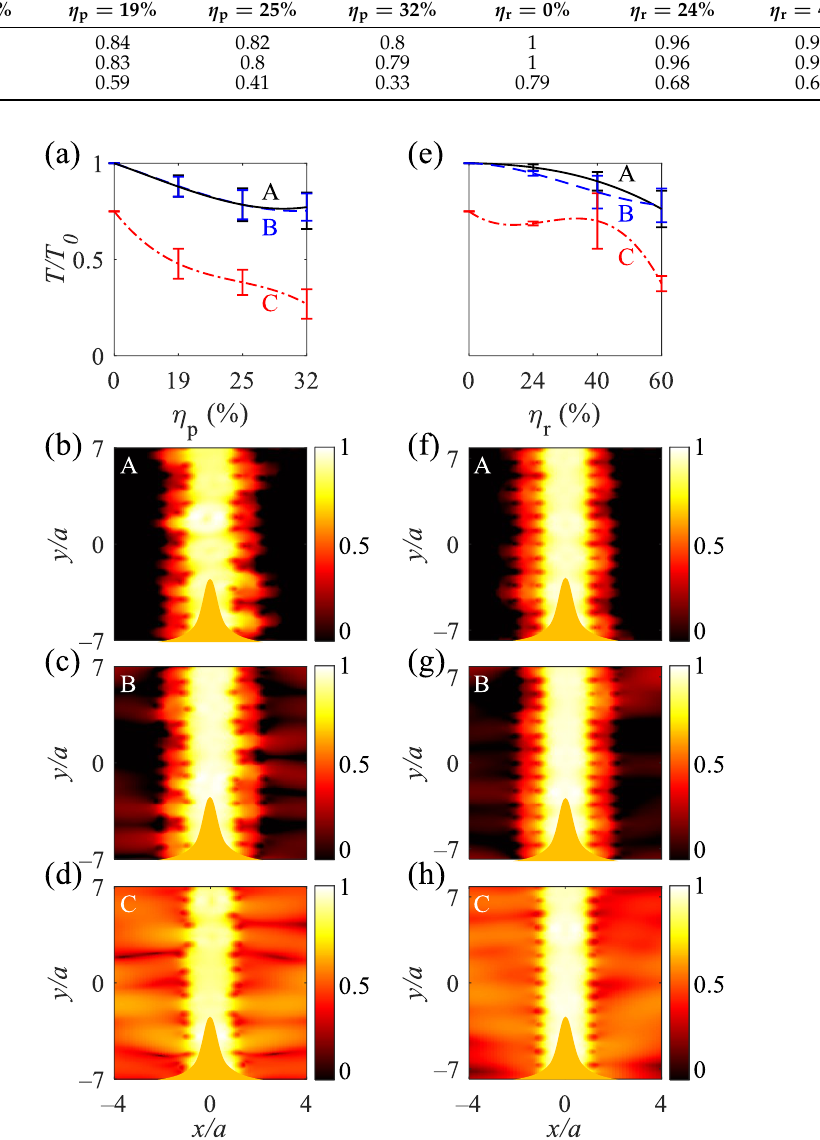
Figure 6. Normalized transmission for the straight A-, B-, and C-type waveguides under the ( a ) position disordering at η p = 19, 25, and 32% and ( e ) radius disordering at η r = 24, 40, and 60%. ( b – d ) Normalized logarithmic electromagnetic power distributions at λ = 490 nm for A, B, and C-type waveguides under η p = 19%. ( f – h ) Normalized logarithmic electromagnetic power distributions at λ = 490 nm for A, B, and C-type waveguides under η r = 24%. The orange bell shapes at the bottom of ( b – d , f – h ) show the TM polarized Gaussian waves, propagating from − y to y , and are recorded at the top of the